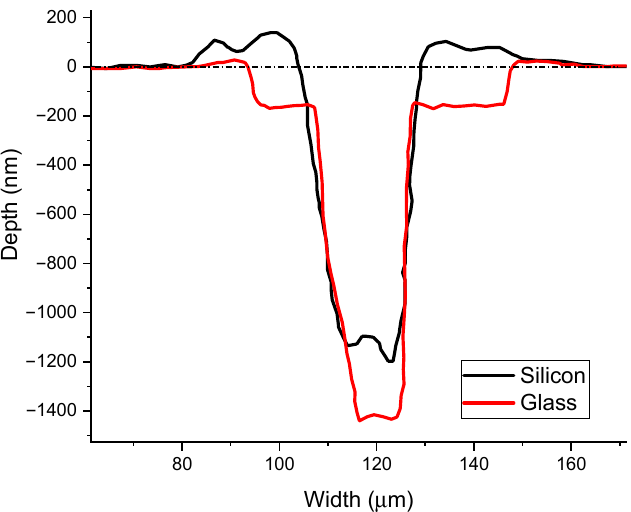
Figure 2. Profilometer scan corresponding to a crater produced by a 0.5 mJ single shot on CdTe thin films grown on silicon substrate and glass.